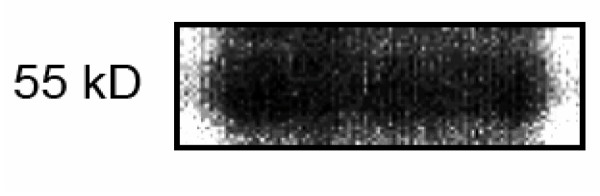
PPAR-γ expression in SVEC endothelial cell. Western blotting for PPAR-γ in SVEC cells reveals a 55 kD band after reacting with anti-PPAR-γ peptide antibody, indicating that PPAR-γ is in fact present within the cells used in this study.